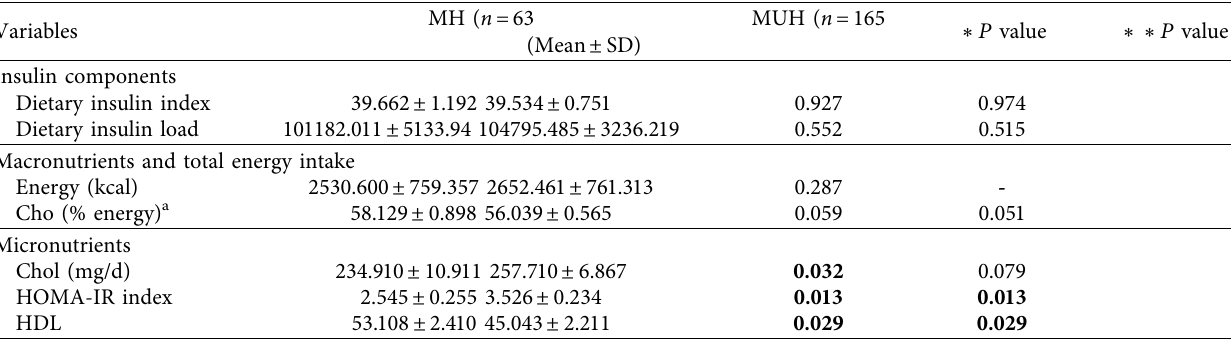
Table 2: Dietary intakes, dietary insulin index, and dietary insulin load among MH/MUH phenotype category in overweight and obese women ( N � 228). Variables